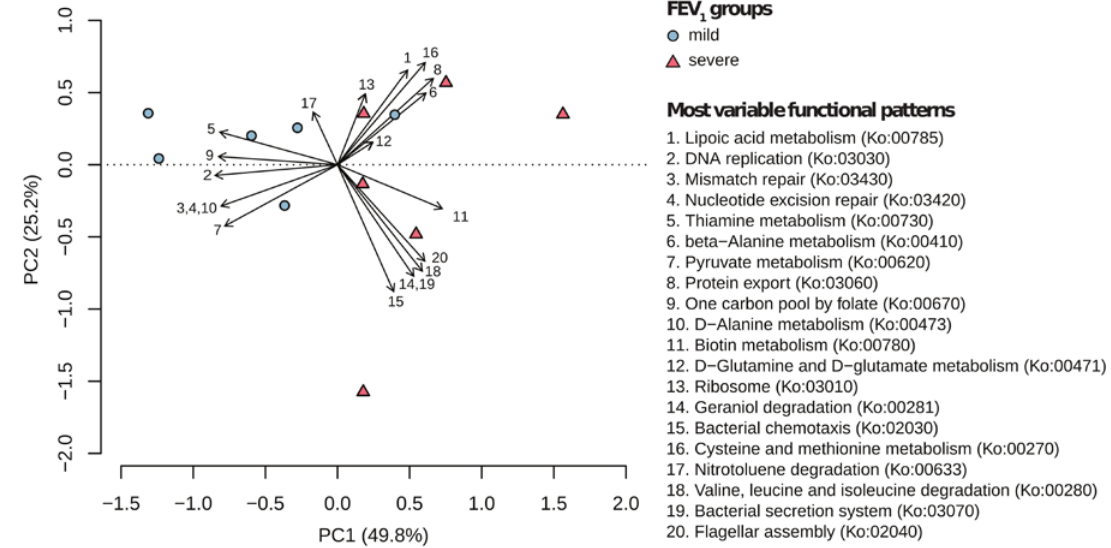
Figure 1. Principal component analysis (PCA) based on the top twenty metabolic patterns. Each number corresponds to a pathway reported in the figure legend, whereas each point corresponds to a different patient. Point shape reflects patient groups.